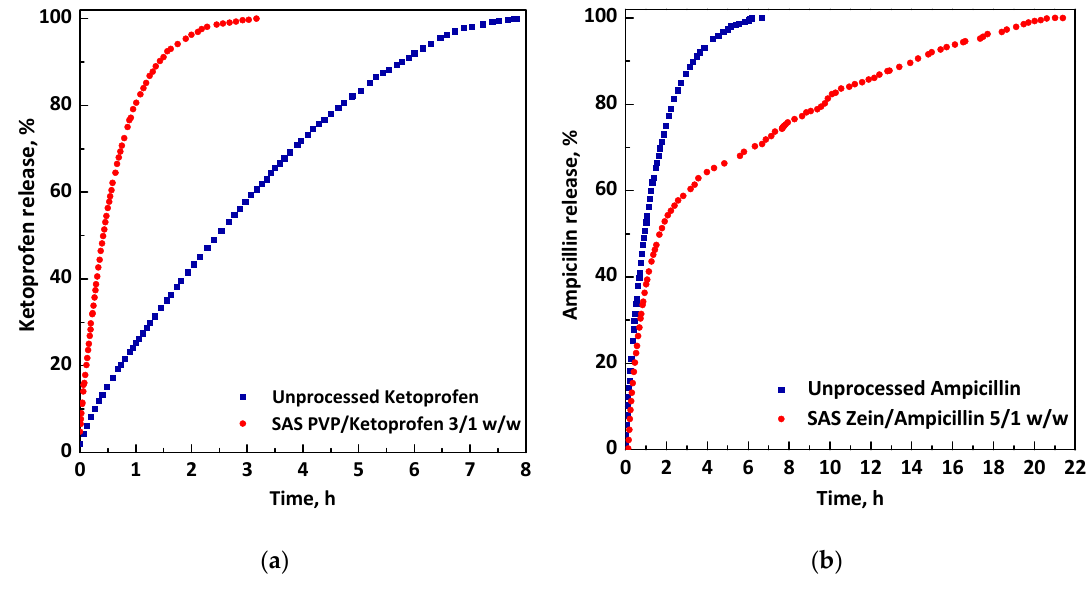
Figure 3. Dissolution kinetics of active principles from microparticles obtained through the SAS process: ( a ) Ketoprofen (pure and released from polyvinylpyrrolidone (PVP)); ( b ) ampicillin (pure and released from zein).